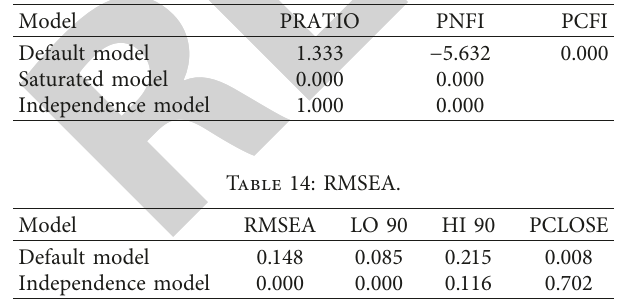
Table 13: Parsimony-adjusted measures.